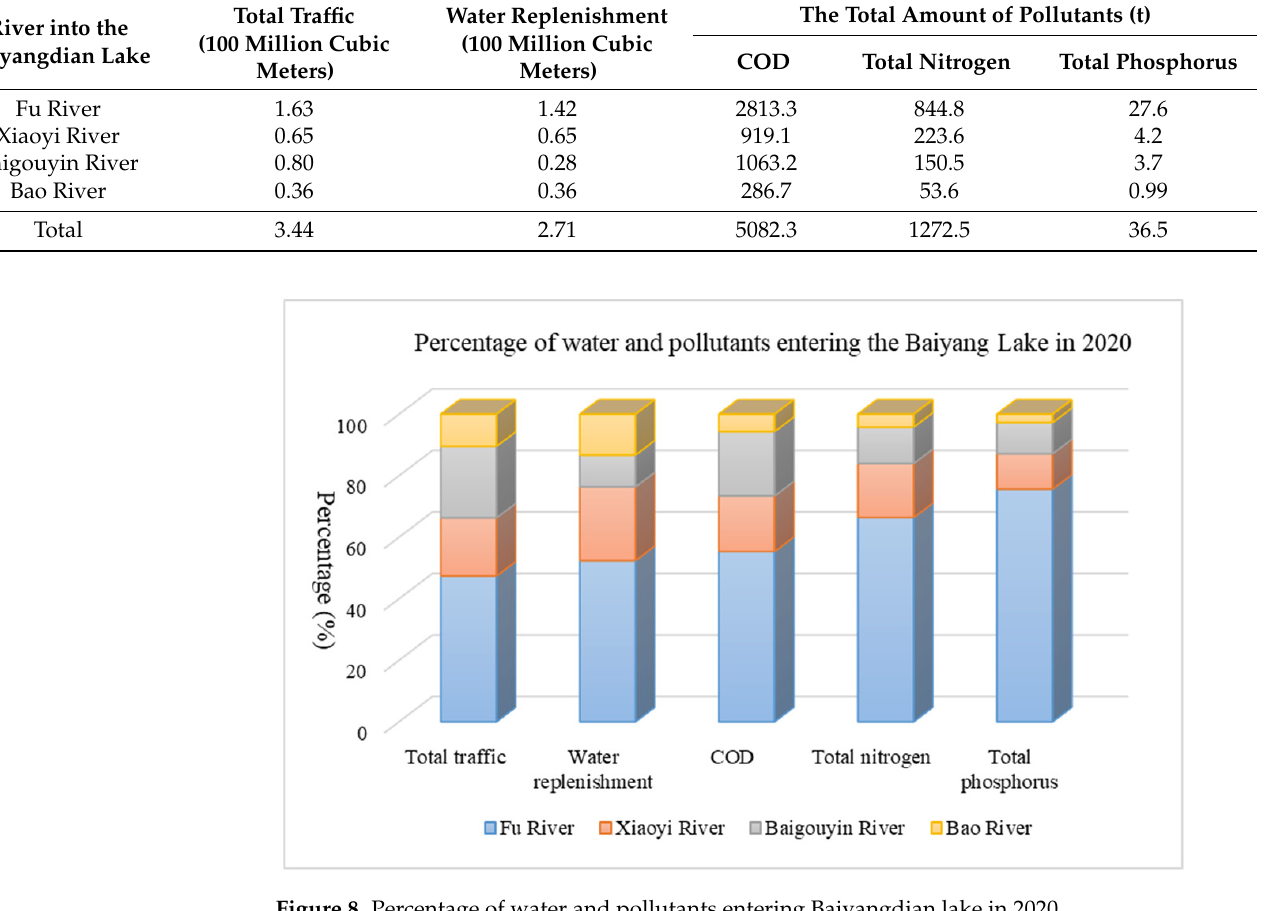
Figure 8. Percentage of water and pollutants entering Baiyangdian lake in 2020.